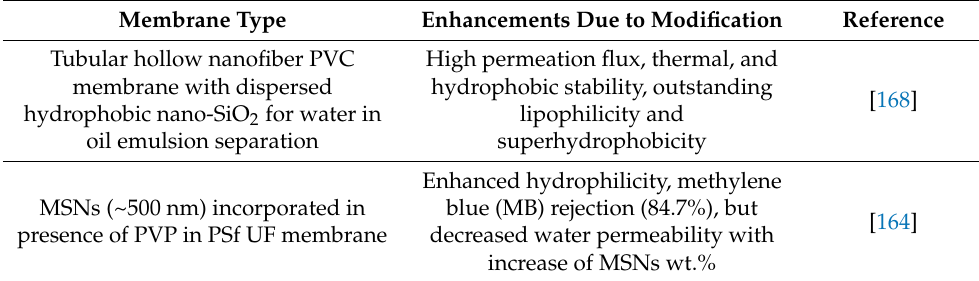
Table 2. A summary of enhancements in properties of SiO 2 nanoparticle-based nanocomposite